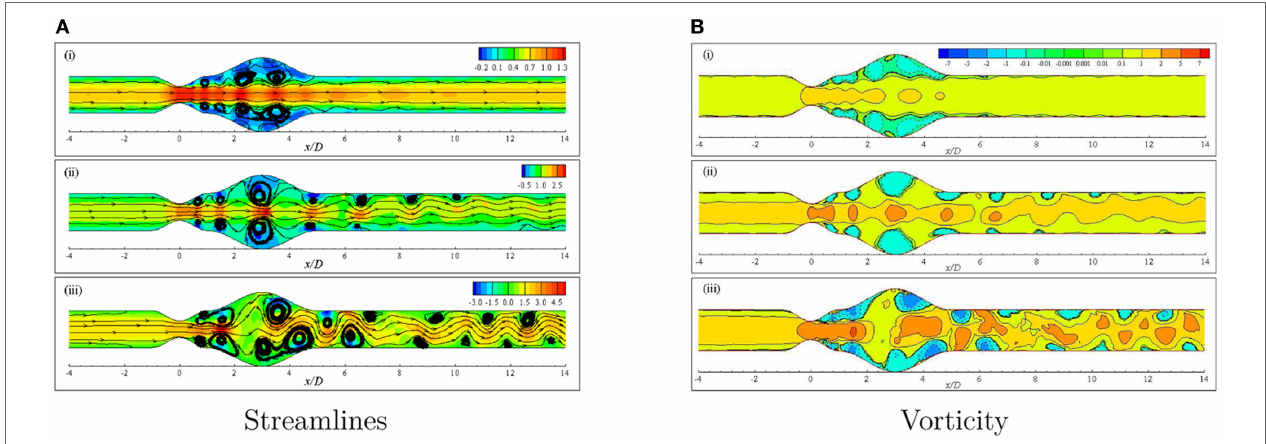
FIGURE 12 | (A) Streamlines and (B) Vorticity when aneurysm = 100% dilated and stenosis = 60% constricted for various Reynolds numbers, i.e., (i) Re = 300, (ii) Re = 500, and (iii) Re = 750 visualizing the transition of the Cross model from laminar to translational where the amplitude of wall oscillation, A = 3 (cid:2) 10 (cid:0) 4 .